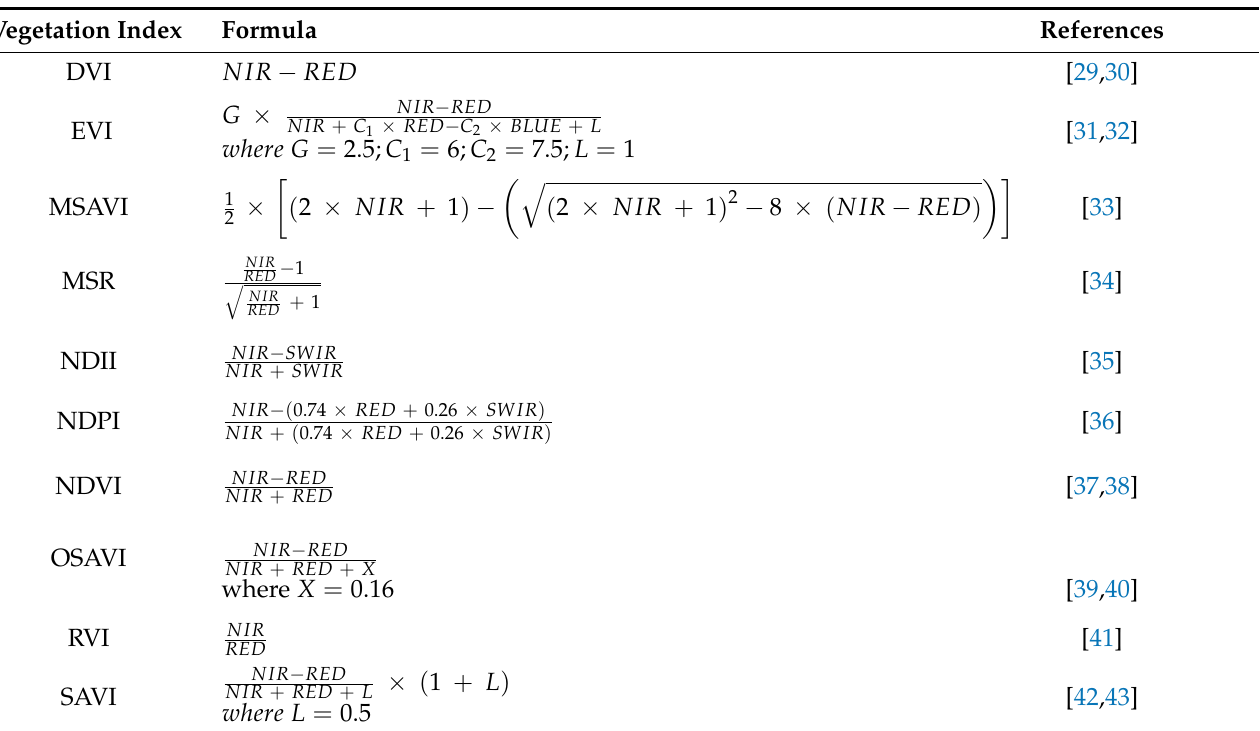
Table 2. Vegetation indices used in the AGB estimation